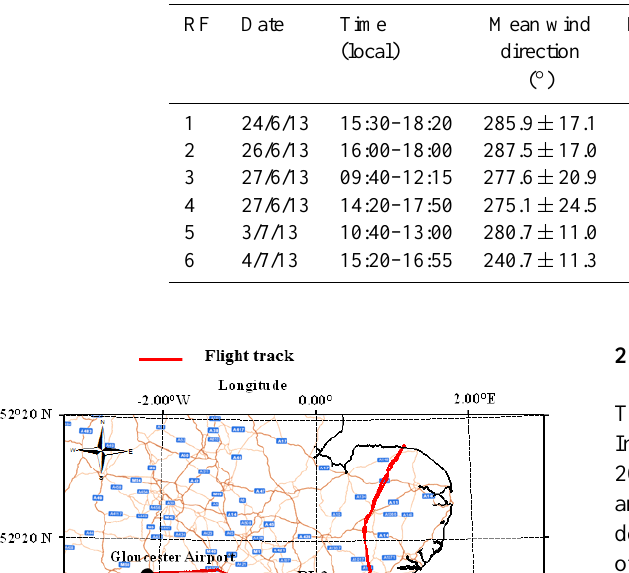
Table 1. Summary of meteorological and flight conditions during campaign.